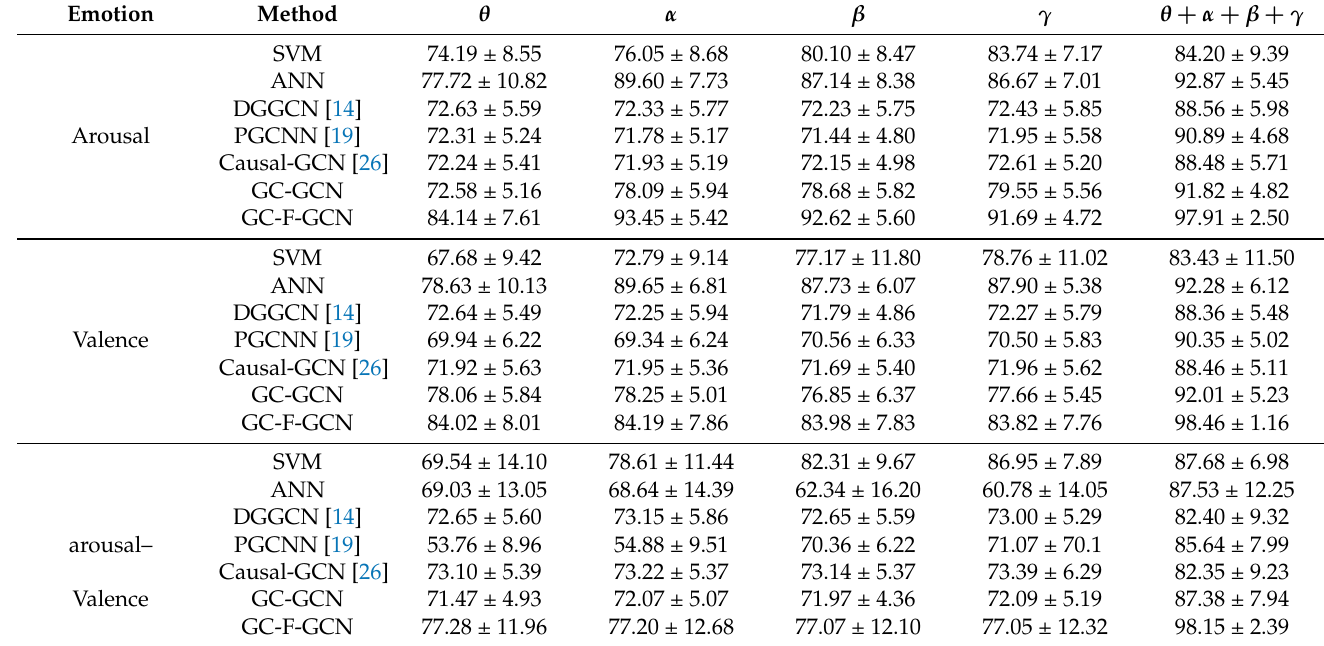
Table 4. The recognition performance with latest schemes (%).